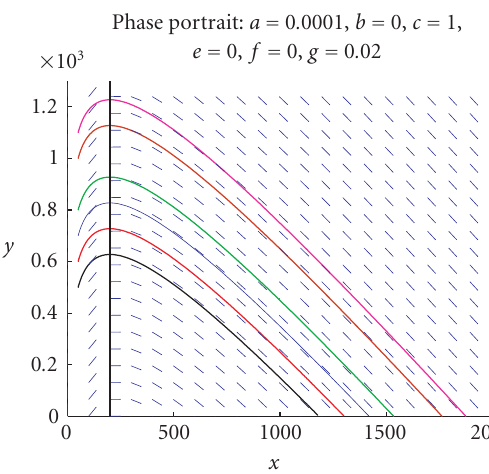
Figure 3.6. The x -axis becomes a line of fixed points when c = 1, and all trajectories end up on the x -axis. The black solid line shows the nullcline at x 0 = g/a = 200. Initial conditions that fall to the left of the nullcline show an increase in the S population before it eventually fades away to